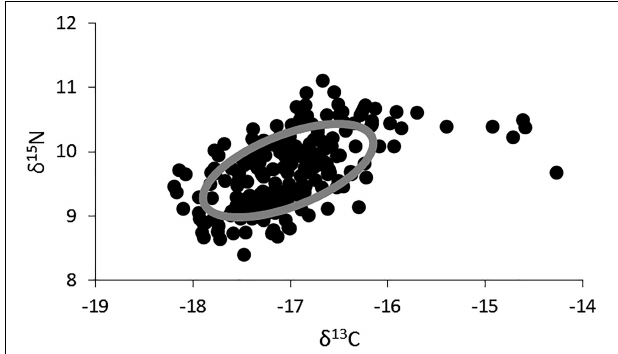
FIGURE 2 | Two-dimensional plot of δ 15 N and δ 13 C values for all individual lionfish (black dots, n = 218) and the overall isotopic niche for lionfish in Bermuda (gray ellipse; SEA c , Standard Ellipse Area, corrected for sample size).